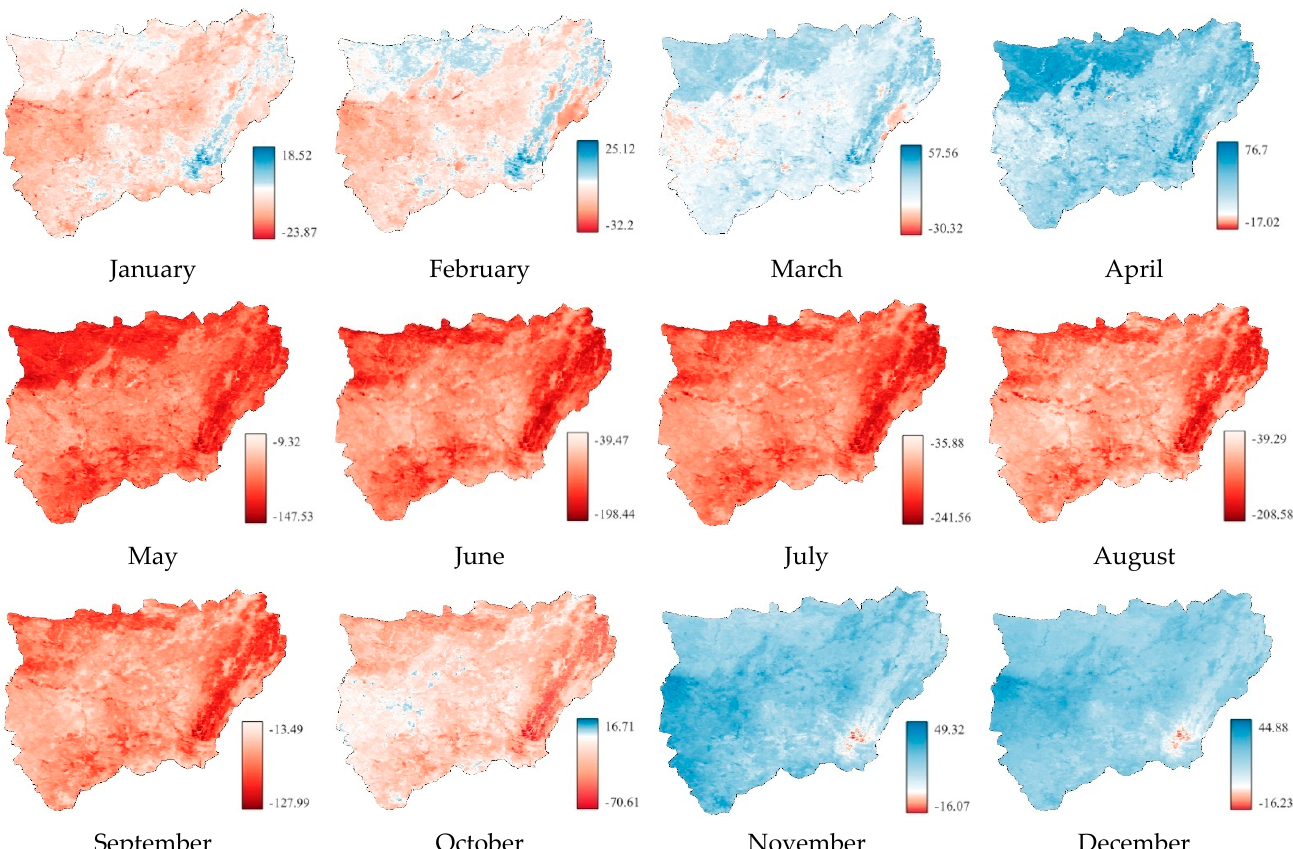
Figure 11. Spatial distribution and values of useful water (AWI) and usable water (SWRC).